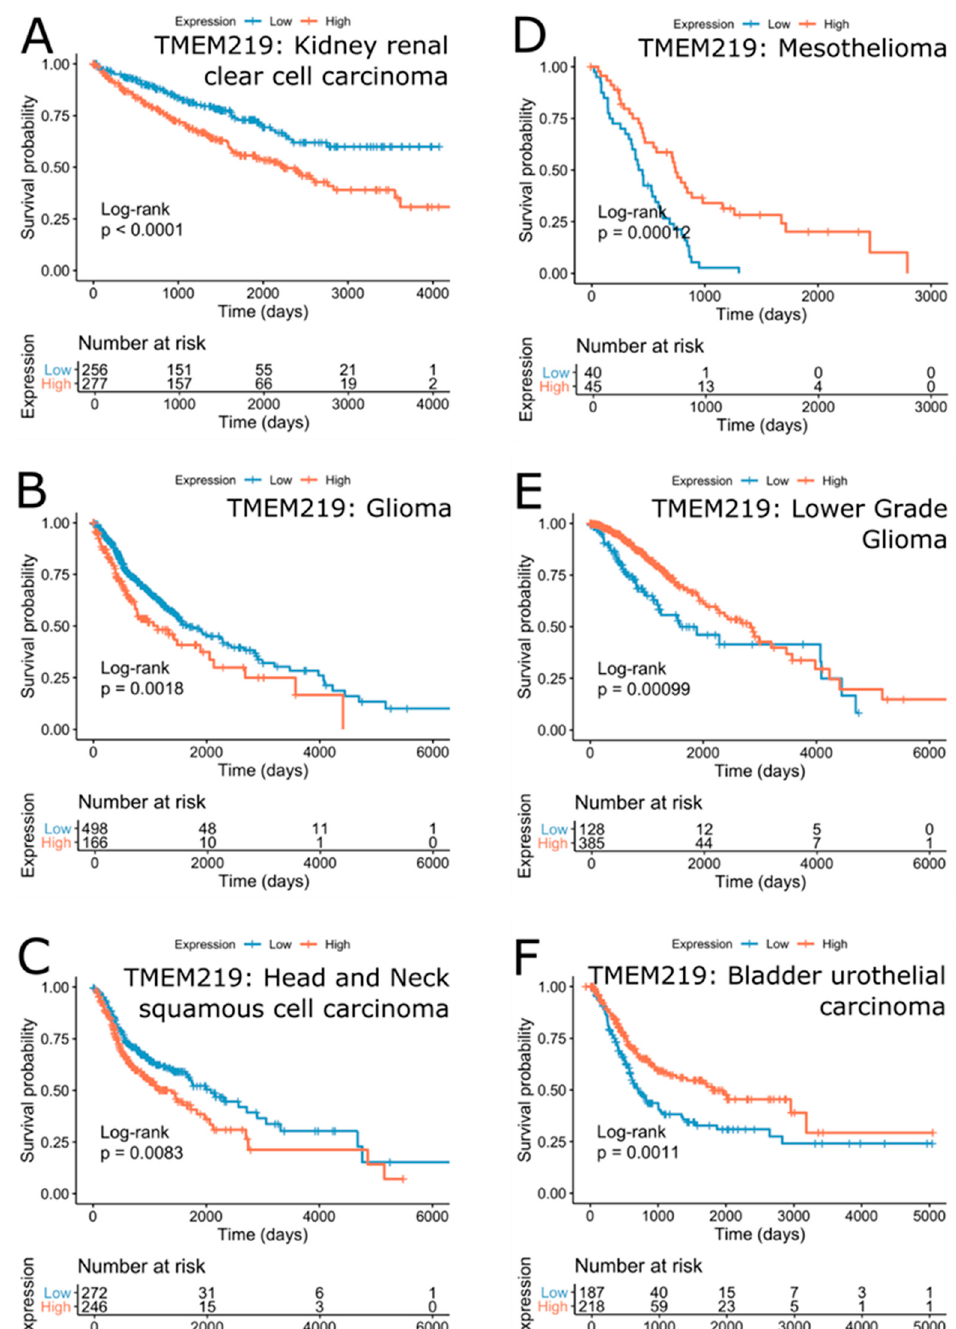
Figure 7. Kaplan-Meier plots of top cancers with survival outcomes separated by the expression of TMEM219 with a negative correlation ( A – C ) and a positive correlation ( D – F ). Unadjusted p -values are